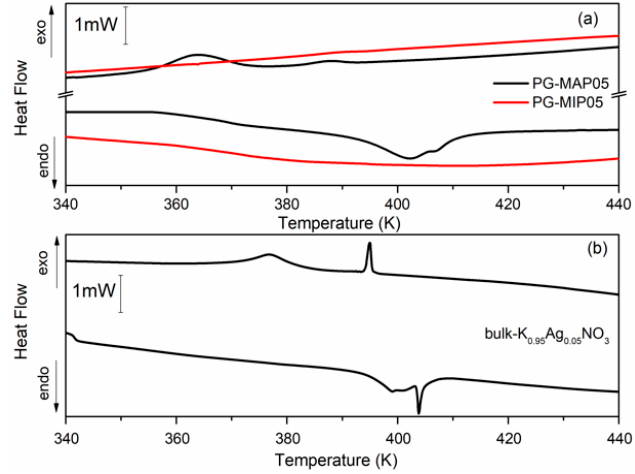
Figure 5. Differential scanning calorimetry (DSC) traces for ( a ) PG-MAP05 and PG-MIP05 nanocomposites and for ( b ) bulk K 0.95 Ag 0.05 NO 3 during the cooling and heating scans (rate: 2 K min − 1 ). Materials 2020 , 13 , x FOR PEER REVIEW 8 of 10